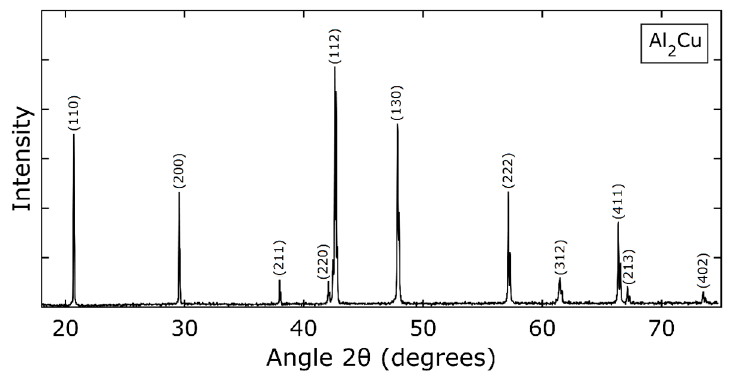
Figure 15. XRD diffraction pattern for corroded EC sample.